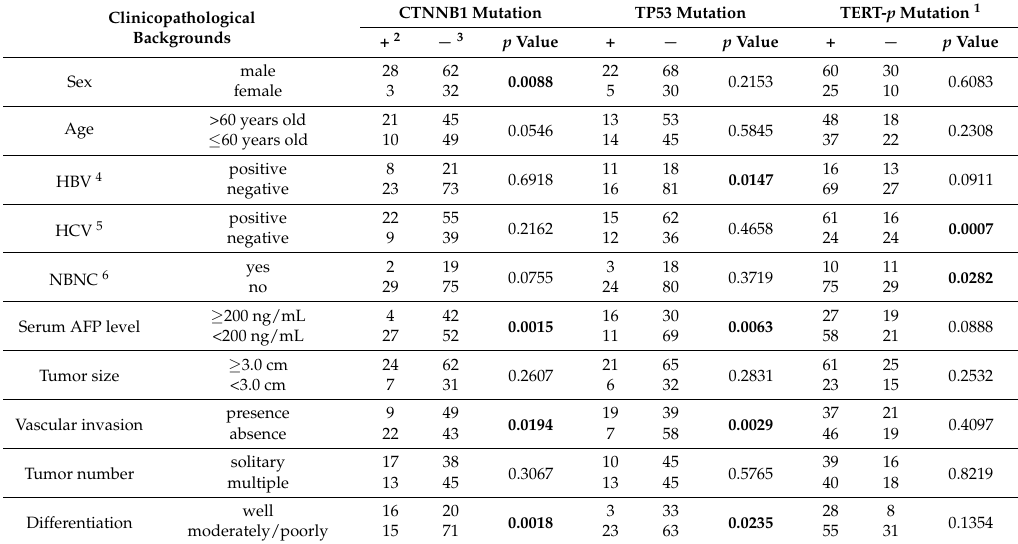
Table 1. Mutation of hepatocellular carcinoma (HCC) and clinicopathological backgrounds in the cohort of liver resection.